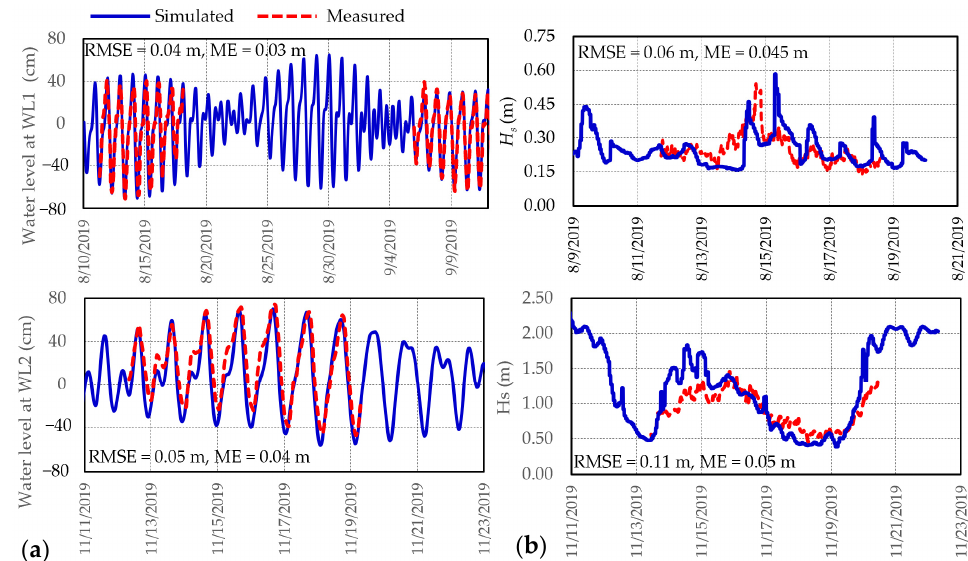
Figure 8. Comparison between ( a ) simulated and observed water levels at TGR1 and TGR2 stations, ( b ) wave heights at SMS station.